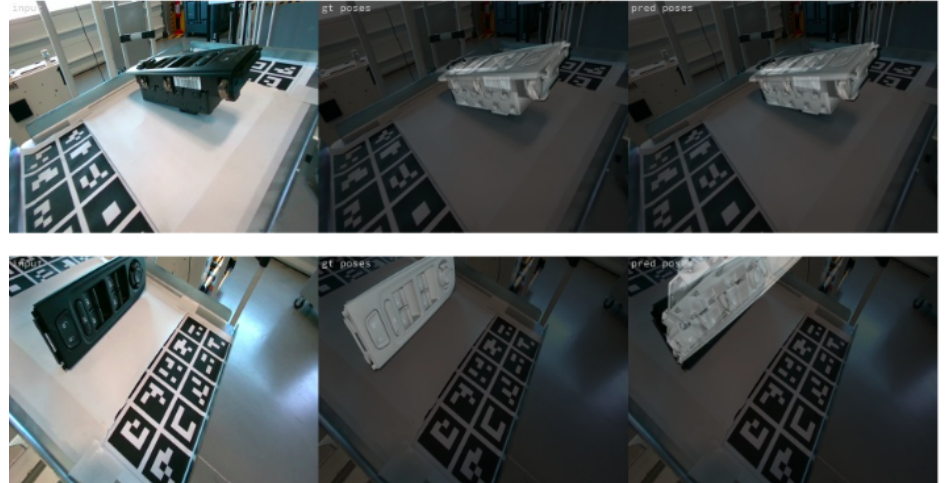
Figure 19. Examples of incorrect predictions on validation images from the real industrial environ- ment. The first column presents the input validation image, the second column the ground truth, and the third one the estimated object pose.